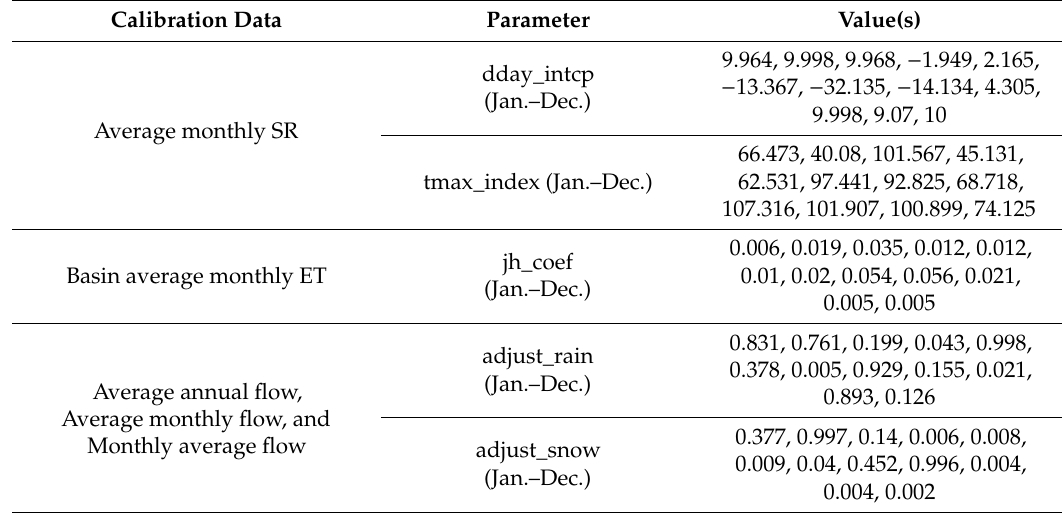
Table A2. The final 21 sensitive parameters values optimized for the reference watershed, as outlined in Table